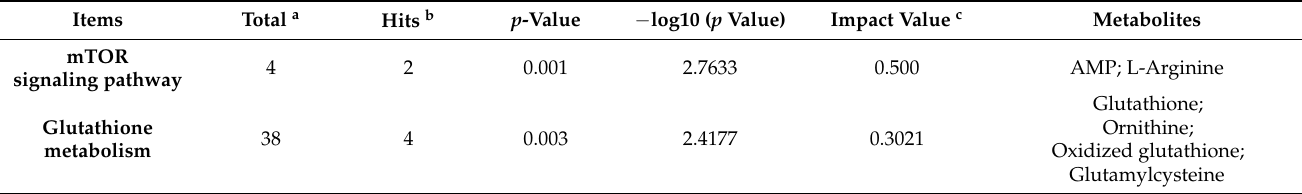
Table 4. KEGG pathway enrichment analysis of differential metabolites between the CH2 and WLS